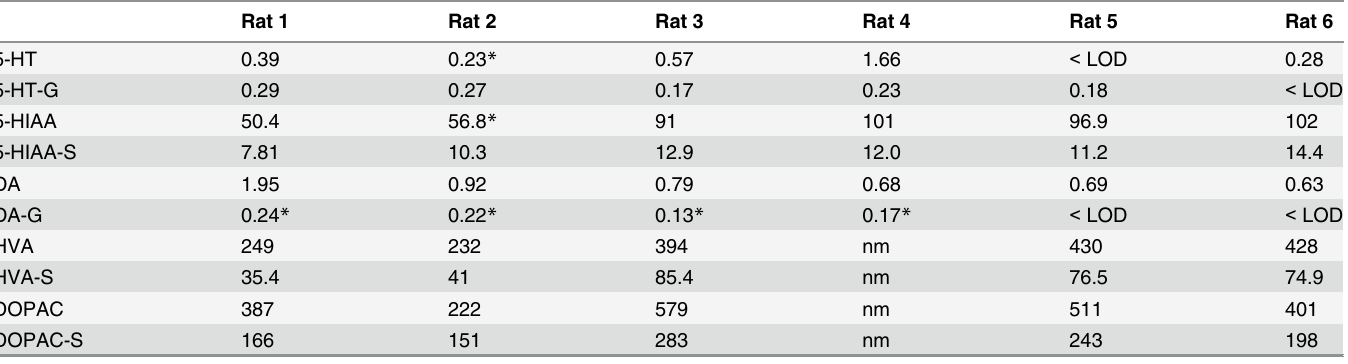
shown to increase DA levels at high doses (3% isoflurane), while the levels of DOPAC and Table 4. Basal concentrations (nM) of the neurotransmitters and their metabolites in rat brain microdialysis samples before the injection. The con- centrations are the average values of the first two time points (0.5 and 1 h) in the experiments.